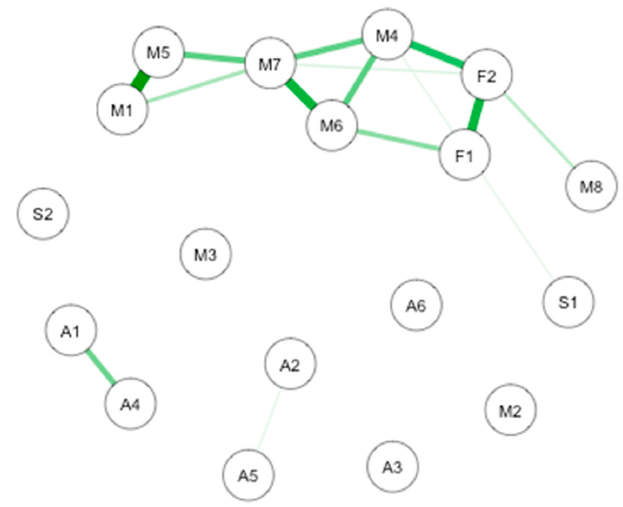
Figure 1. GLASSO-regularized partial Pearson correlation networks of interoception subscales, mindfulness subscales, and subjective olfactory acuity, resulting from all the subjects. Green edges denote positive associations, red edges negative ones. F1: Freiburg Mindfulness Inventory (FMI) presence; F2: FMI Non-judgmental acceptation; S1: Scale of Positive and Negative